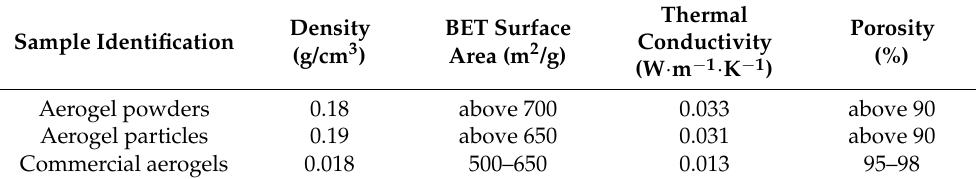
powders. The broad peaks at about 3465 cm − 1 and 1630 cm − 1 show a weaker absorption intensity; they are -OH groups due to the H 2 O absorbed through KBr during FTIR test. Obviously, the peaks of aerogel powder at 1083 cm − 1 and 467 cm − 1 have a complete silica network, corresponding to the asymmetric stretching vibration of Si-O-Si bonds [27].